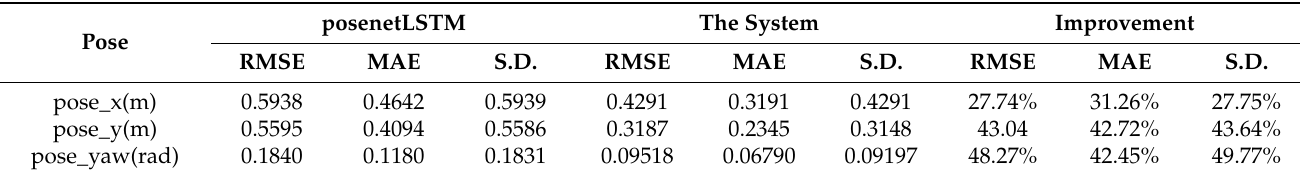
Table 1. The result of the metric absolute speed error when robot is in motion.